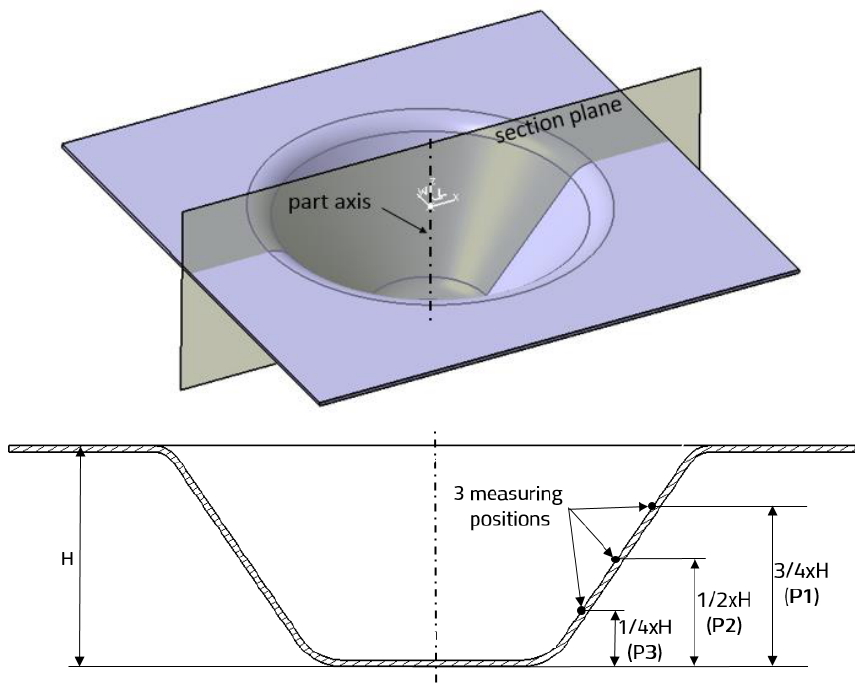
Figure 12. The parts measurements positions, adapted with permission from ref. [5].